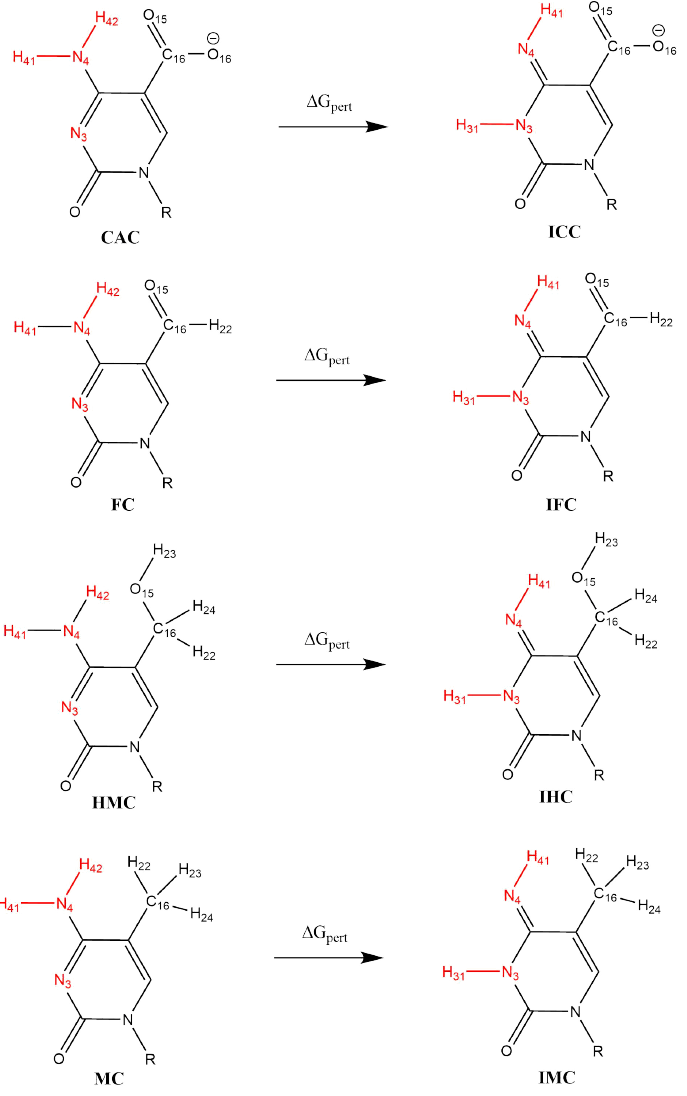
Figure 4. Scheme of alchemical perturbations from amino to imino forms of the oxidised methyl- cytosines. Atoms in the soft core region are shown in